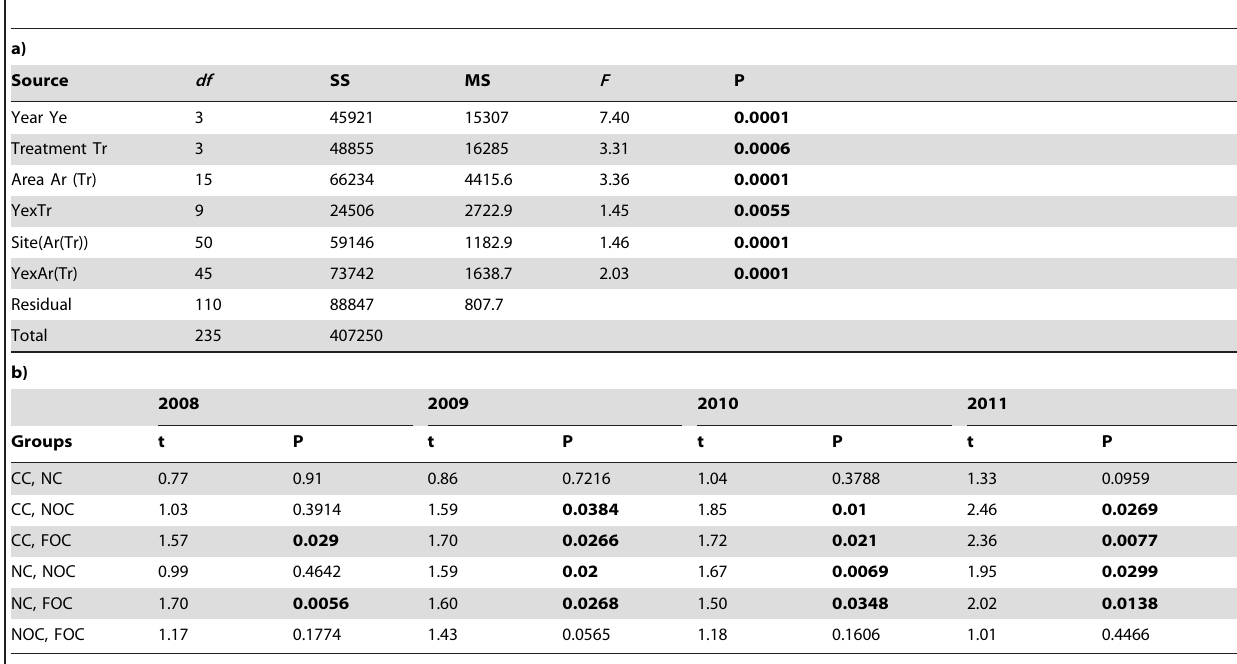
Table 3. PERMANOVA of assemblage composition based on Bray Curtis similarity